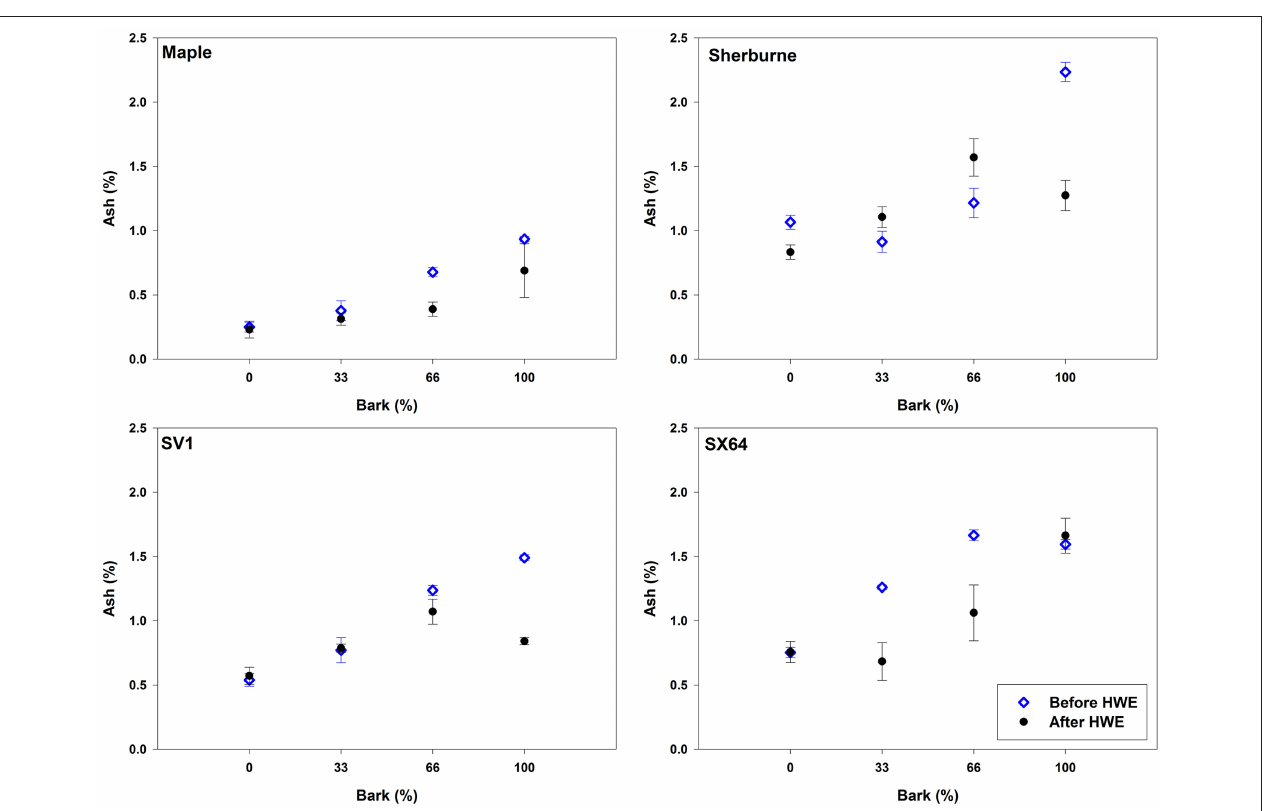
FIGURE 1 | Ash content of sugar maple and three willow cultivars with bark levels ranging from 0 to 100% before and after HWE.